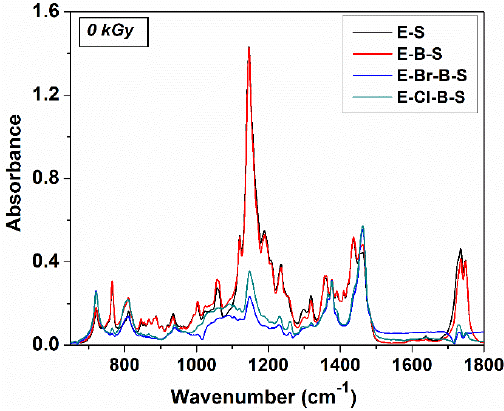
Figure 8. FTIR spectra of non-irradiated EPDM based composites.